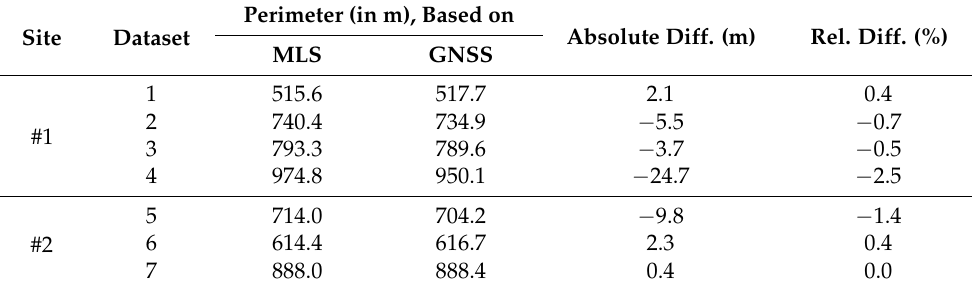
Table 2. The absolute and relative differences between perimeters based on GNSS and MLS. The relative differences were calculated as absolute difference divided by MLS-based perimeter and multiplied by 100.